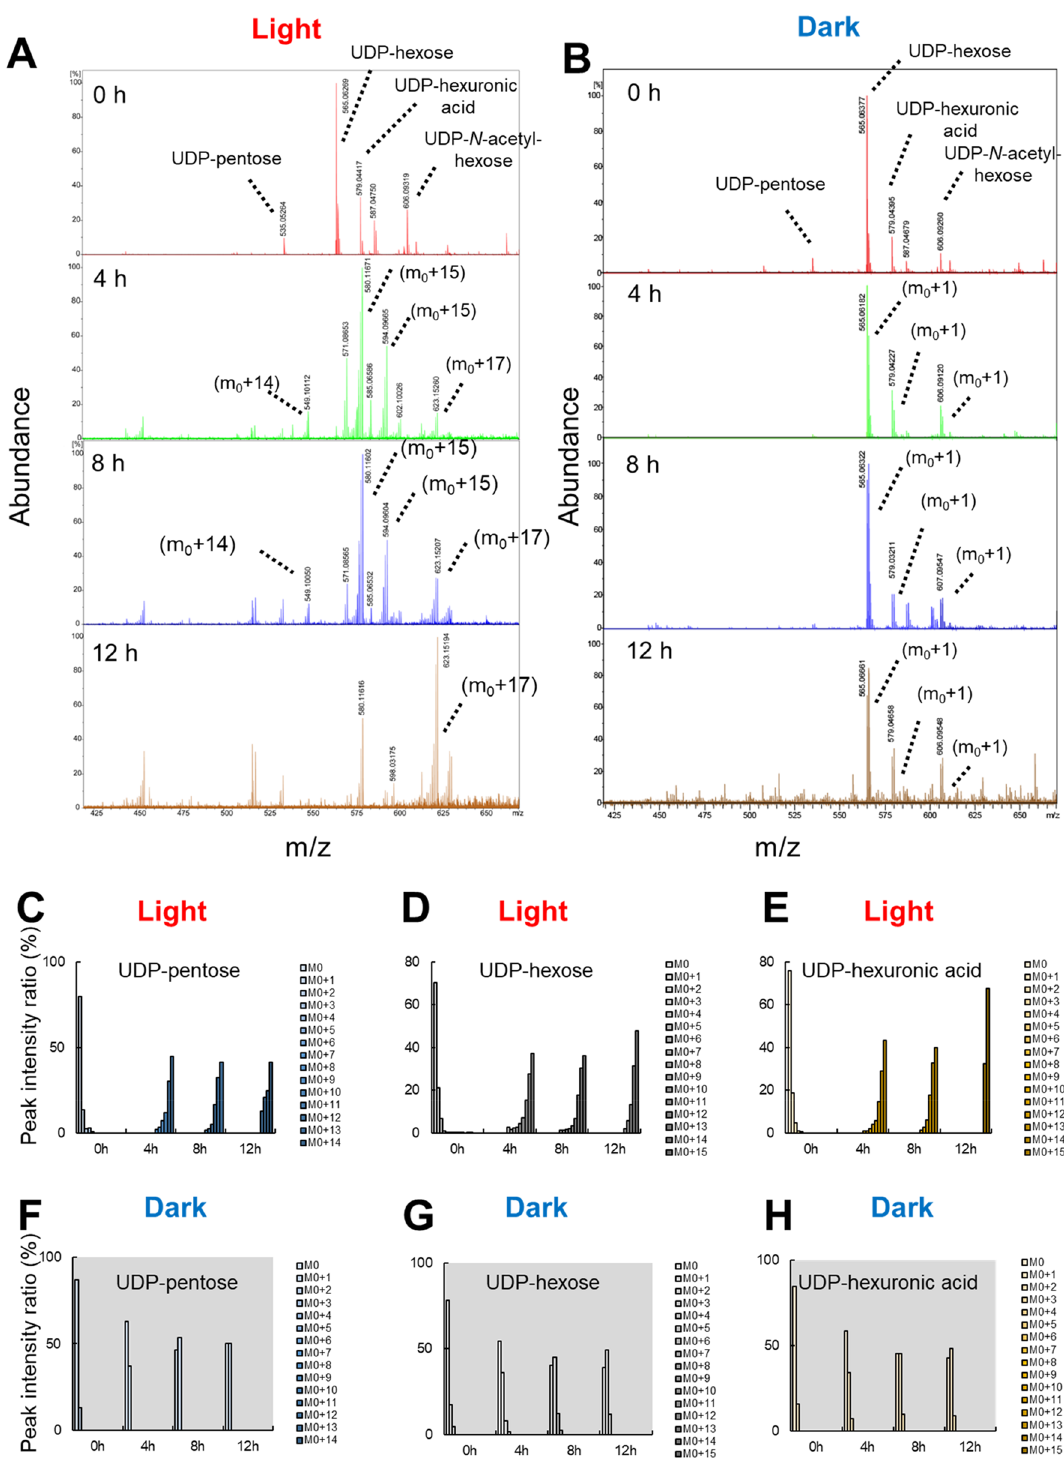
Figure 2. FT-ICR-MS analysis of 13 C-incorporated nucleic diphosphate sugars produced under ( A ) light and ( B ) dark conditions. Comparisons of monoisotopic mass (M 0 ) and 13 C-labelled mass (M 0 + X , X = 1–15) under ( C – E ) light and ( F – H )